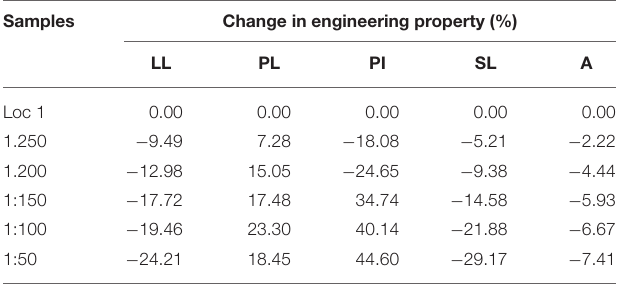
TABLE 8 | Percentage changes in atterberg limits.